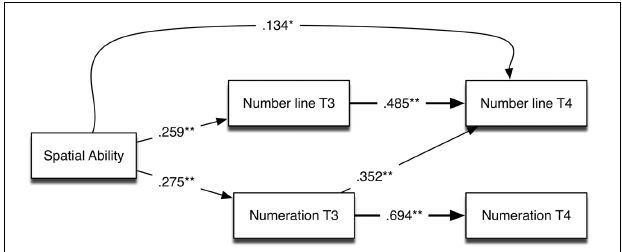
FIGURE 2 | Path analysis showing longitudinal relations among spatial FIGURE 3 | Path analysis showing longitudinal relations among spatial ability, number line performance, and Calculation ( R 2 = 0 . 356, and ability, number line performance, and Numeration ( R 2 = 0 . 351, and 0.584 for number line at T3 and T4, respectively; R 2 = 0 . 563 and 0.611 0.617 for number line at T3 and T4, respectively; R 2 = 0 . 578 and 0.482 for Calculation at T3 and T4, respectively). ∗∗ p < 0 . 01. for Numeration at T3 and T4, respectively). The residual variances between number line and Numeration were not significant at either Time 3 or Time 4. ∗ p < 0 . 05; ∗∗ p < 0 . Table 3 | Significant effects (standardized) of spatial ability on number line and calculation at Time 4. β